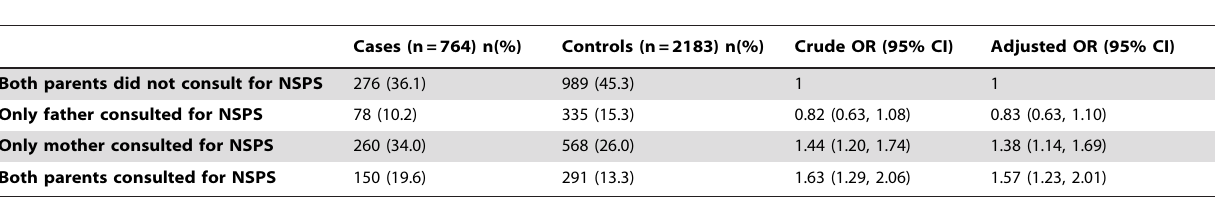
Table 4. Associations between consultations for NSPS in both parents and children.